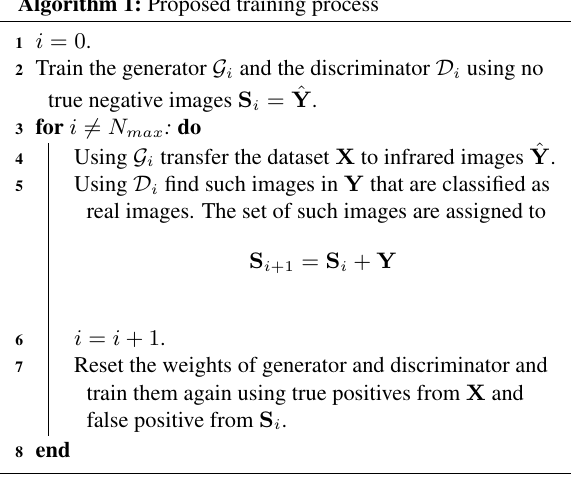
Algorithm 1: Proposed training process